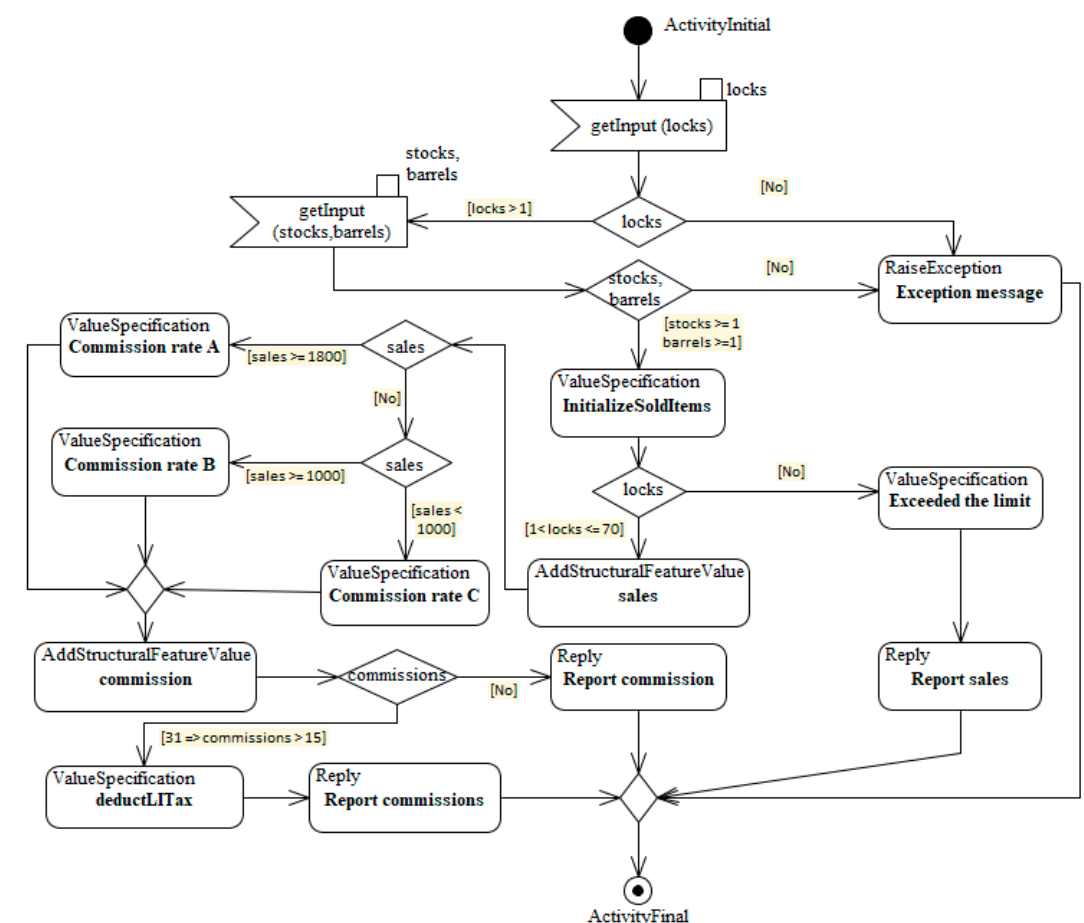
Figure A1. The commission problem activity diagram.